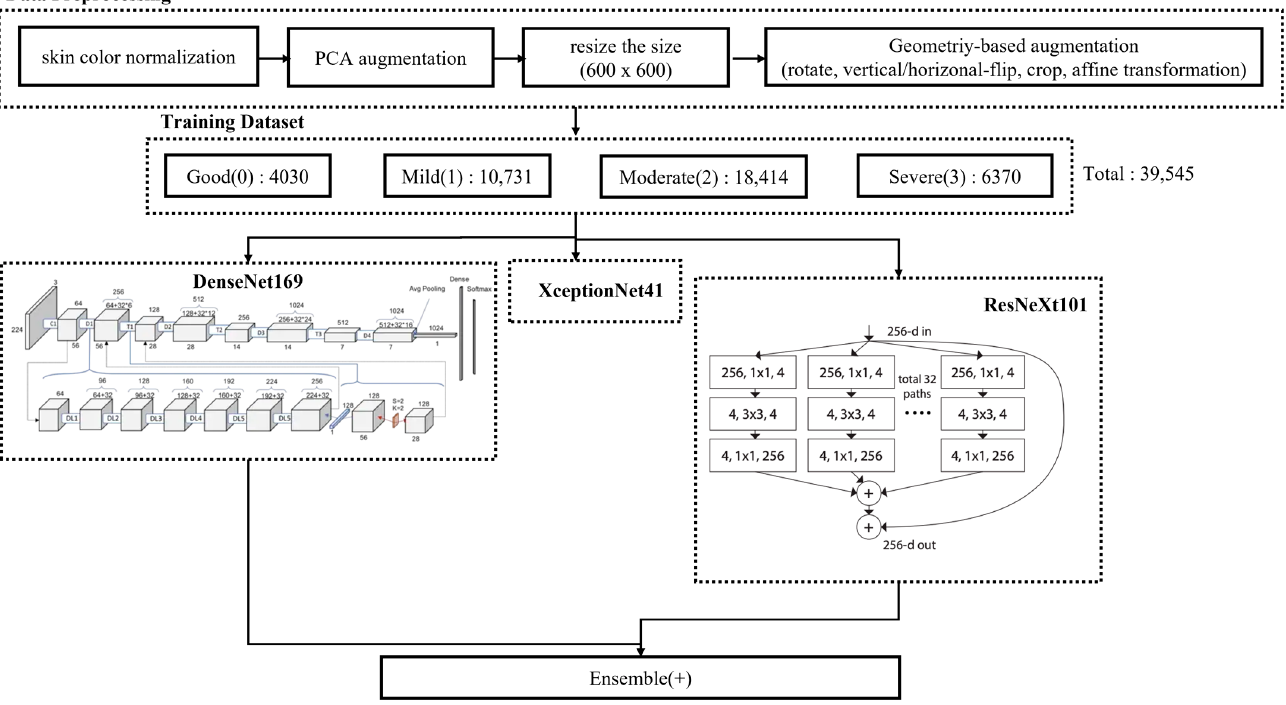
Figure 3. Deep learning model architecture for alopecia classification. The final process for the input data and data augmentation for forming the ensemble is represented in Figure